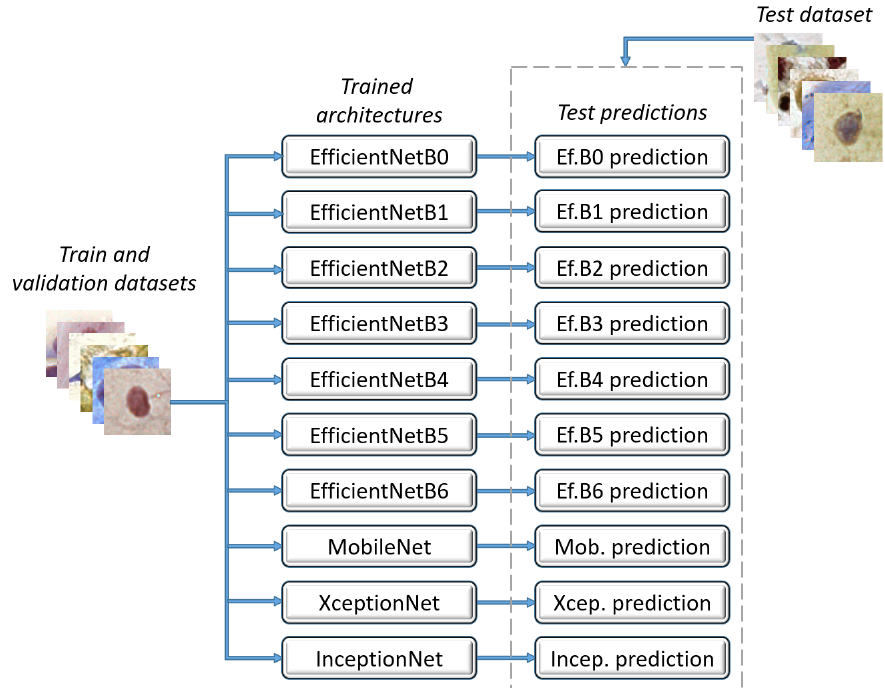
Figure 3. Convolutional neural network